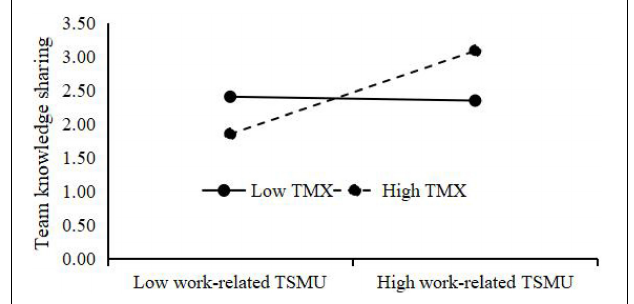
FIGURE 3 | Interactive effect of work-related TSMU and TMX on team knowledge